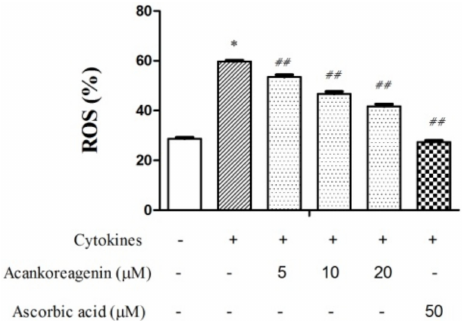
Figure 7. Effects of acankoreagenin on the cytokine-induced ROS levels in RIN-m5F cells. The RIN-m5F cells were pretreated with the indicated concentrations of samples for 1 h and then IL-1 β (10 ng/mL) and IFN- γ (100 ng/mL) were added for 24 h. The intracellular ROS generated was detected by flow cytometry after 30-min incubation with an oxidation-sensitive probe DCFH-DA treatment. * p < 0.05 versus vehicle-treated control; # p < 0.05 and ## p < 0.01 versus cytokine-treated group. Bars indicate SEM ( n =